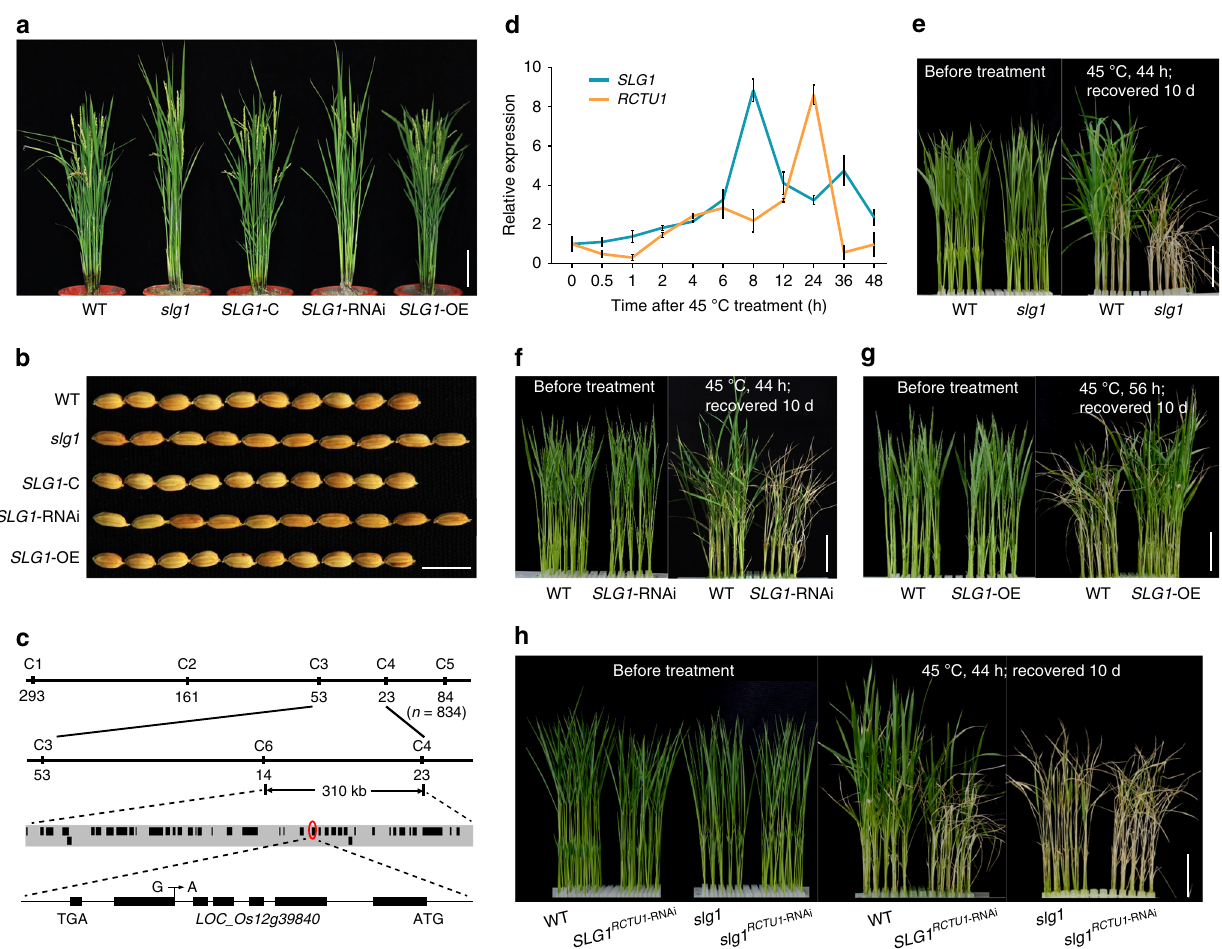
Fig. 1 SLG1 is a positive regulator of thermotolerance. a , b Phenotypes of whole plant and grain shape of slg1 , WT, and the transgenic T 2 lines of slg1 -C, SLG1 -RNAi, and SLG1 -OE. C, complementation; OE, overexpression; RNAi, RNA interference. Bars = 10 cm ( a ) and 1 cm ( b ). c Fine mapping of the SLG1 gene. A single-nucleotide substitution at the splicing acceptor site of the fi fth intron of LOC_Os12g39840 in slg1 was indicated. d SLG1 and RCTU1 show high- temperature-inducible expression. Total RNA was extracted from the shoots of 2-leaf-stage seedlings at the indicated time-points. The expression levels were determined by qPCR, and the expression level at time 0 was set to 1. Actin was used as the internal control. Data are means ± SD ( n = 3 biological replicates). e – g SLG1 is a positive regulator of thermotolerance. Phenotypes of WT, slg1 , SLG1 -RNAi, and SLG1 -OE plants before and after treatment are shown. Bars = 5 cm. h Dysfunction of RCTU1 shows thermosensitive phenotype similar to the slg1 mutant. Phenotypes of RCTU1- RNAi plants on the background of slg1 and WT are shown before and after treatment. Bar = 5 cm. The source data underlying ( d ) are provided as a Source data fi